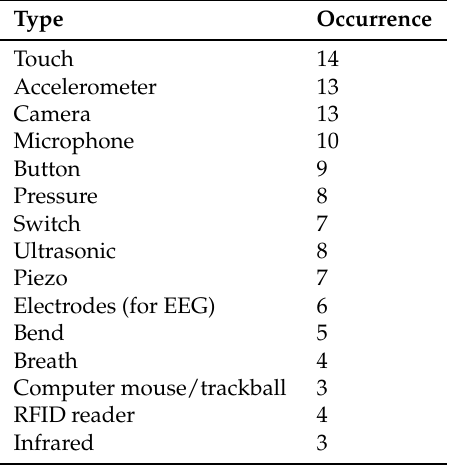
Table 4. Frequently Used